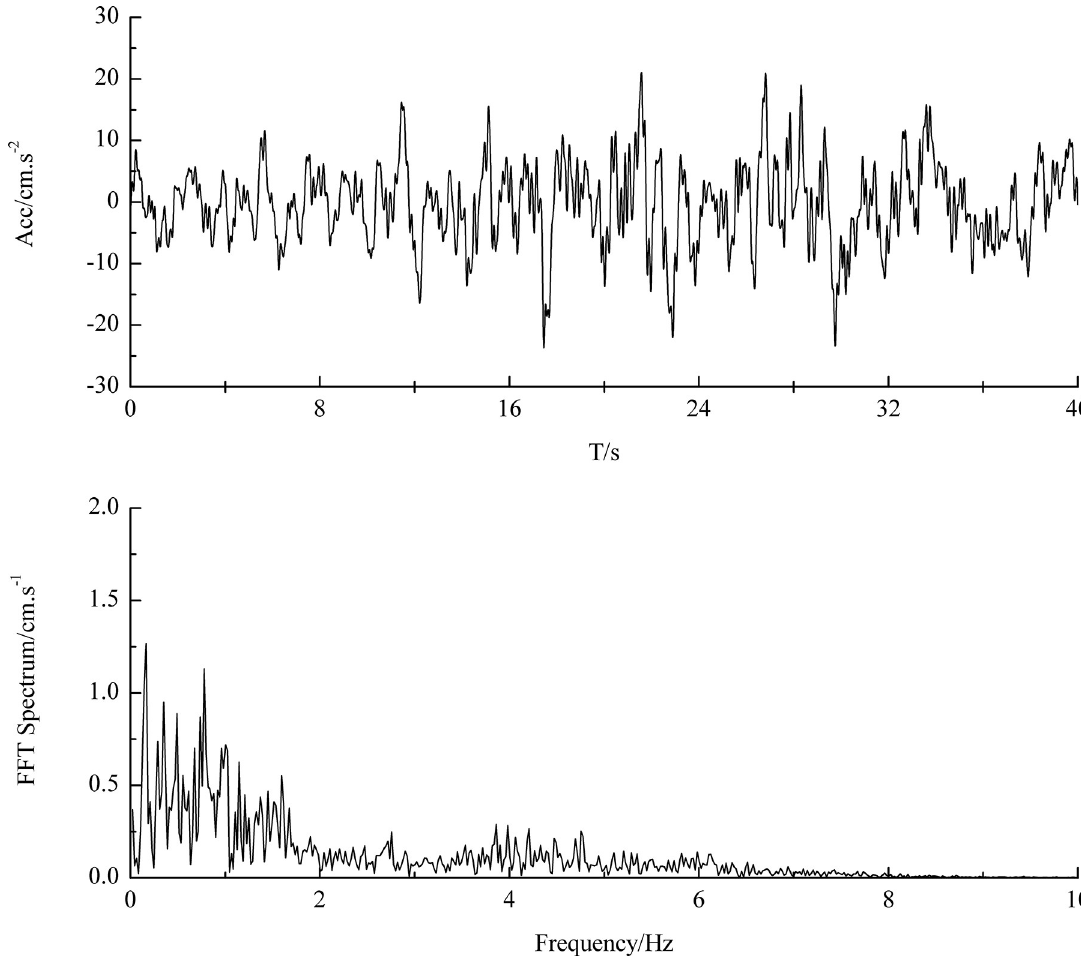
Fig 1. Horizontal acceleration history at Wuquan mountain during Wenchuan